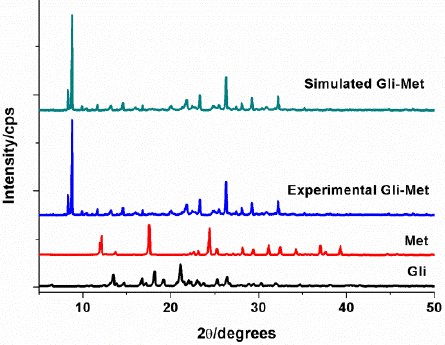
ff ractograms of Gli-Met, Met and Figure 1. X ‐ ray powder diffractograms of Gli ‐ Met, Met and Gli. Figure 1. X-ray powder di